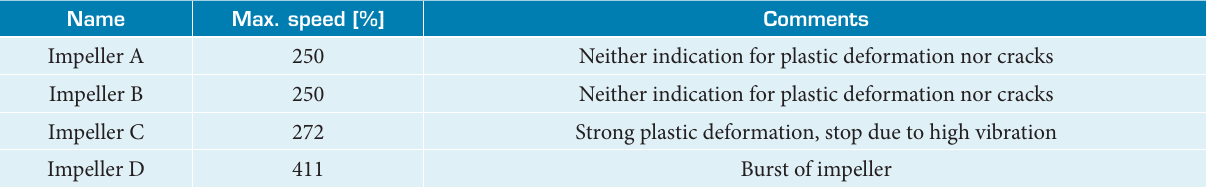
Table 3. Summary of LOx impeller burst